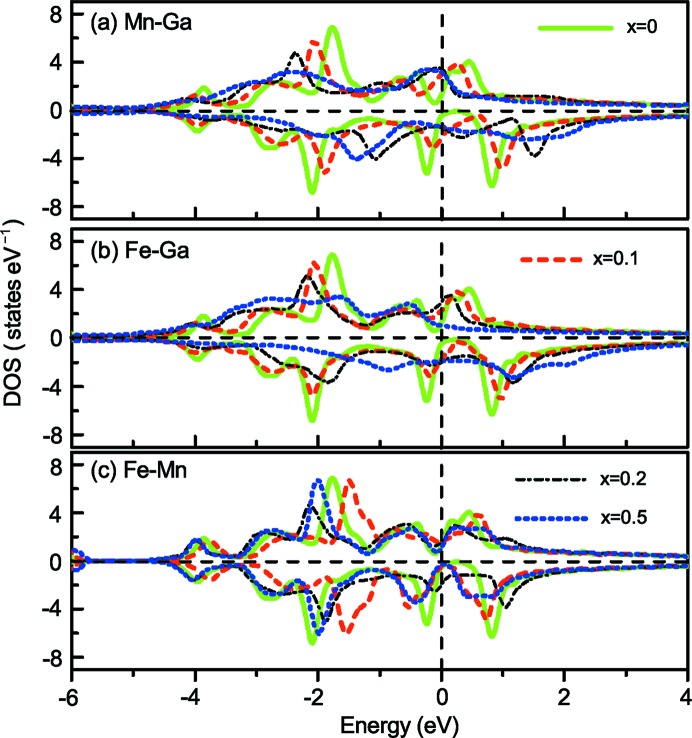
DOS based on the CPA for (a) Fe(Mn1−xGax)(Ga1−xMnx), (b) (Fe1−xGax)Mn(Ga1−xFex) and (c) (Fe1−xMnx) Mn1−xFex) Ga disorder.